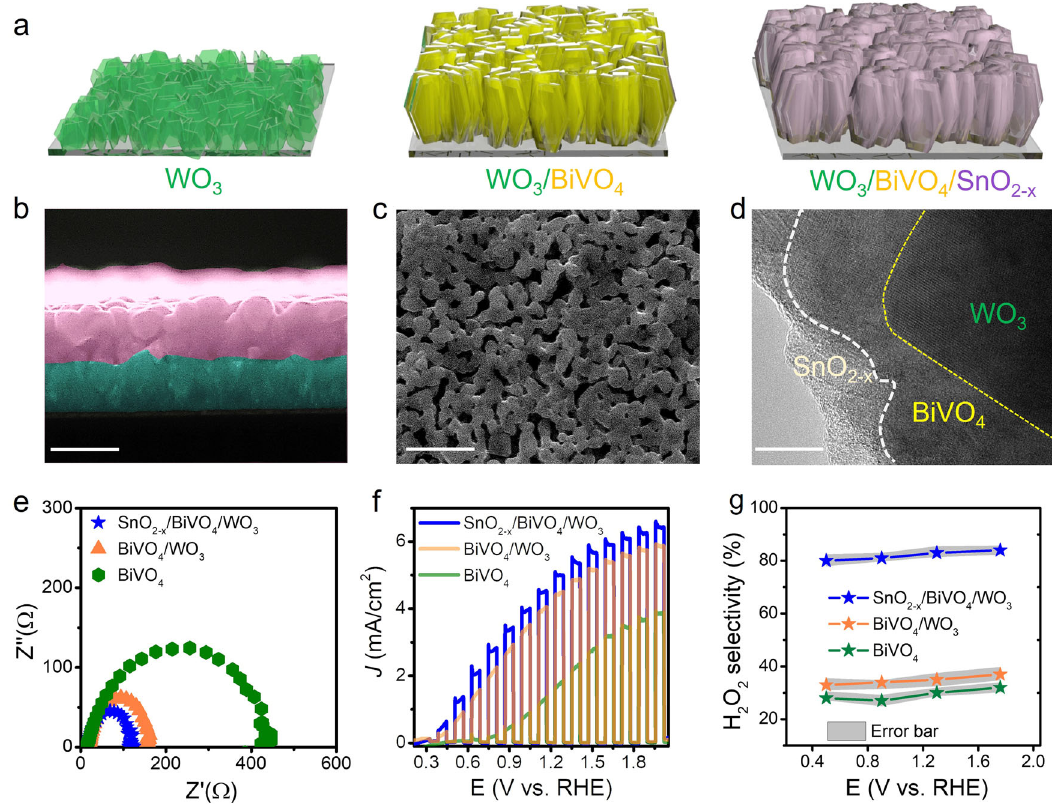
Fig. 3 | Multiheterostructure photoanode for effective H 2 O 2 production. a Scheme of the construction of the heterostructure of SnO 2-x /BiVO 4 /WO 3 . b SEM cross-sectional image of SnO 2-x /BiVO 4 /WO 3 . Scale bar: 500nm. c SEM surface image of SnO 2-x /BiVO 4 /WO 3 . Scale bar: 500nm. d HR-TEM image of SnO 2-x /BiVO 4 / WO 3 ,Scalebar:5nm. e EISscanofBiVO 4 ,BiVO 4 /WO 3 ,andSnO 2-x /BiVO 4 /WO 3 under